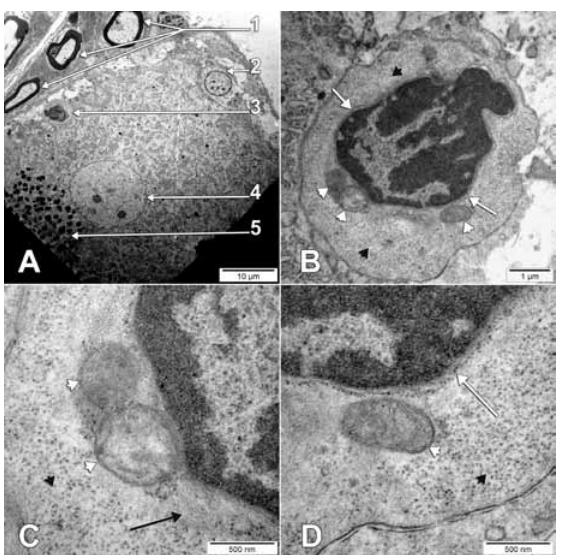
Figure 3. Ultrathin cut of human adult trigeminal ganglion. A.General view. 1.myelinated fibers; 2.satellite glial cell; 3.quiescent SGC; 4.nucleus (with two nucleoli); 5.lypofus - cin. The quiescent SGC (detailed in B, C, and D) has a pro - genitor phenotype: heterochromatic nucleus, the nuclear envelope is coated by ribosomes (white arrows), contains a few perinuclear mitochondria (white arrowheads), inter - mediate filaments (black arrow) and the cytoplasm is filled with free ribosomes (black arrowheads).